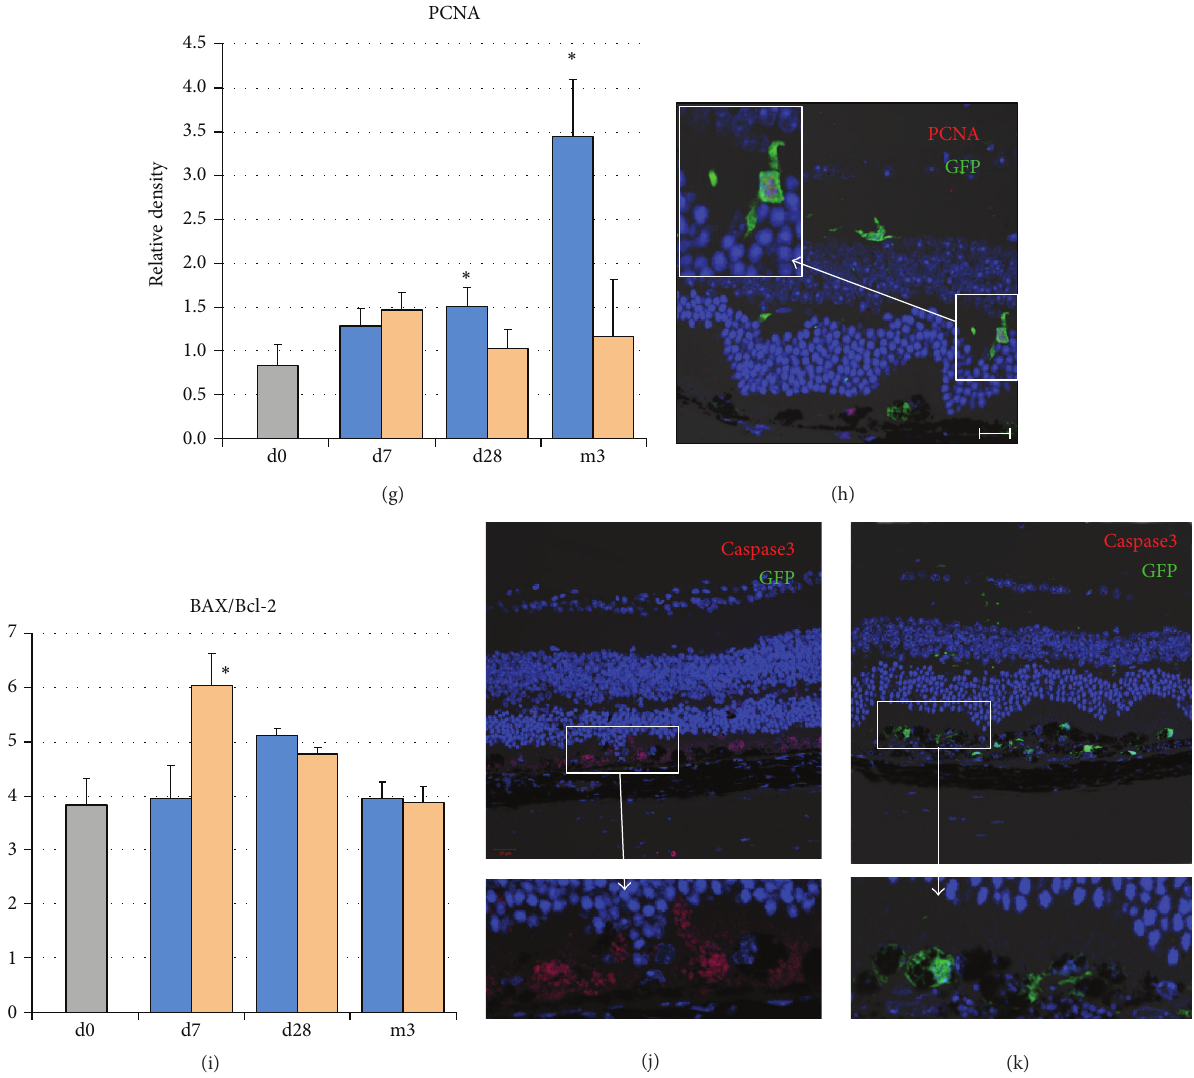
Figure 4: Molecular analyses of potential in vivo effects of Lin − BMCs on injured retinas at different time points post injury. BDNF mRNA (a) and BDNF protein (b-upper panel) expression time course analyses show a significant increase in Lin − BMC-treated eyes compared to PBS-injected eyes on the 7th day after transplantation. Immunoblotting for the BDNF, pMAPK, tMAPK, PCNA, and active caspase-3 of retinal lysates collected from control, uninjured animals (Control), PBS injected and Lin − BMC-treated mice on d7, d28, and m3 after injury (b). Double-stained retinal sections (anti-BDNF and anti-GFP) were used to visualize the coexpression of BDNF and GFP cell markers